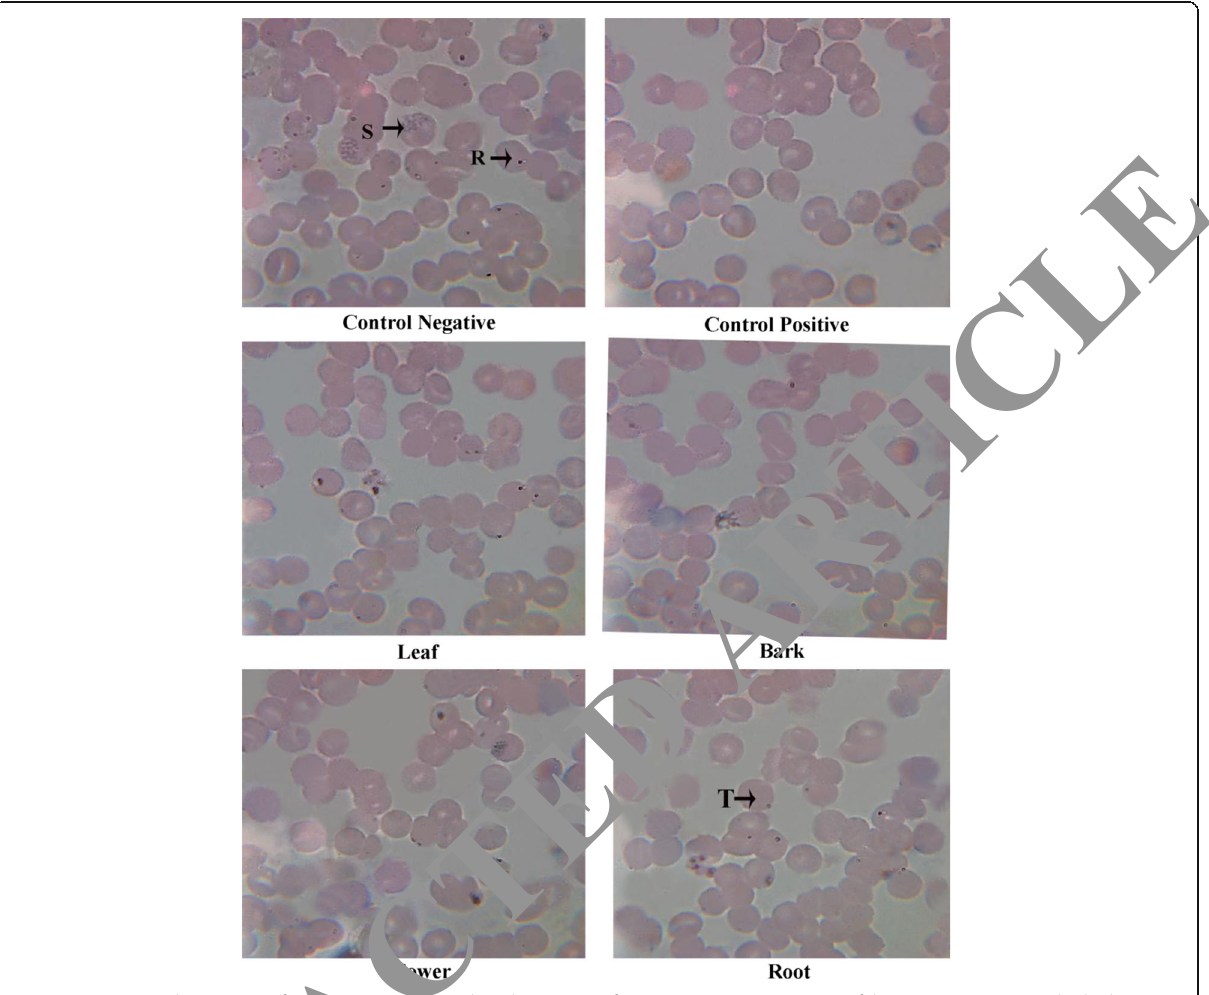
Fig. 3 Microscopic observations after treatment with methanolic extracts of Pongamia pinnata against P. falciparum 3D7 strain at the highest concentration (200 μ g/mL) with Giemsa stain at 1000× magnification (R- ring stage, T- trophozoite, S- schizont)